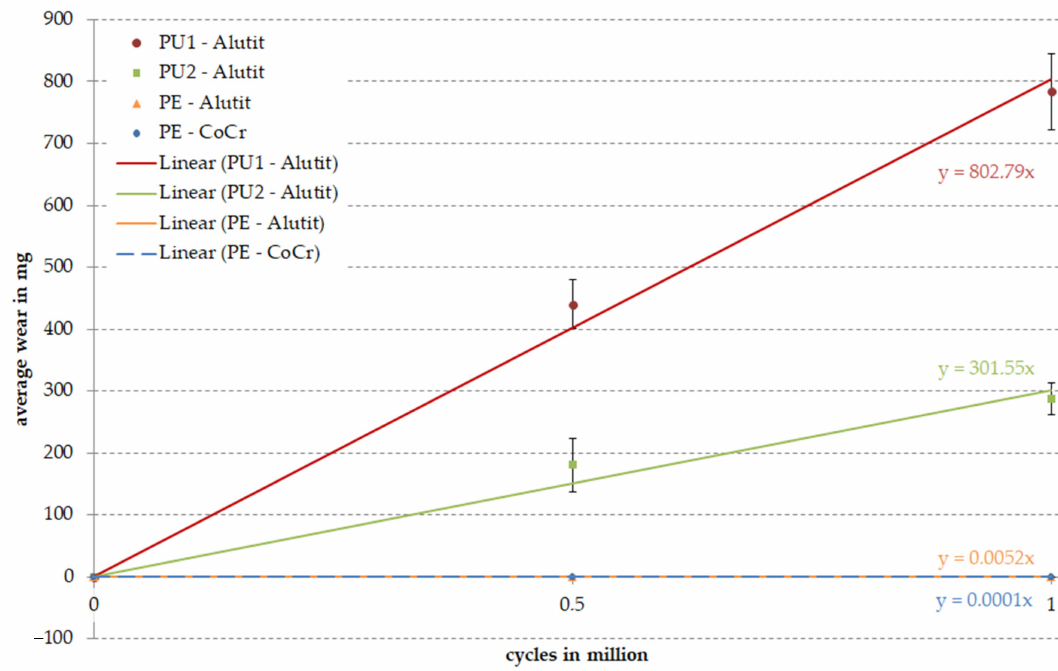
Figure 6. Overall wear of samples after loading in the rolling-sliding test bench. The straight line results from linear re- gression of the data for estimating the abrasion after 1 million cycles. Different to ISO 14243–1, the zero time point is used in this calculation.